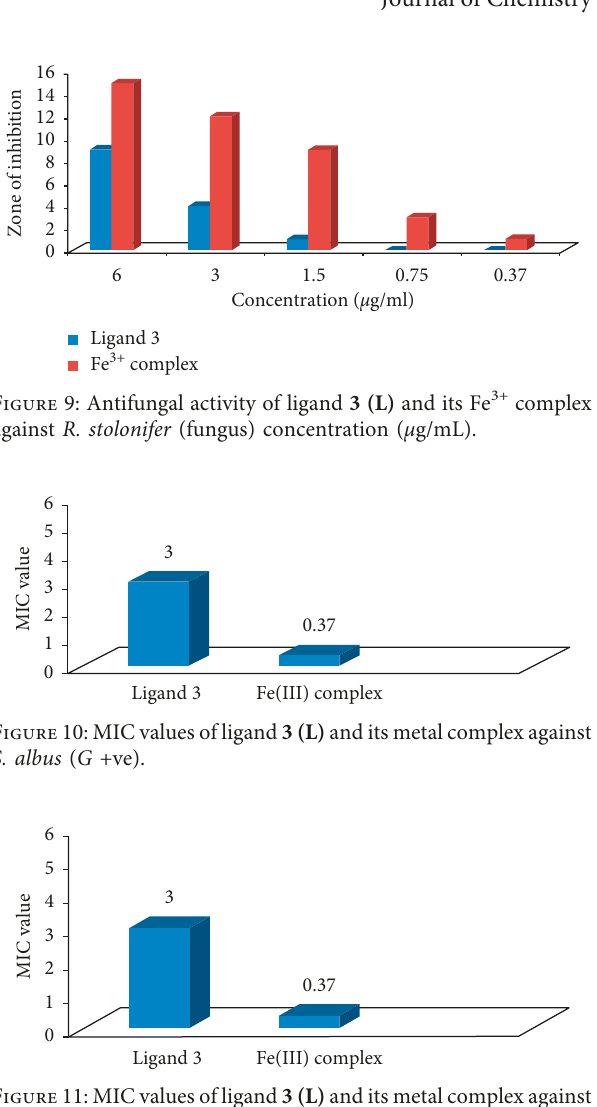
Figure 11: MIC values of ligand 3 (L) and its metal complex against E. coli (G